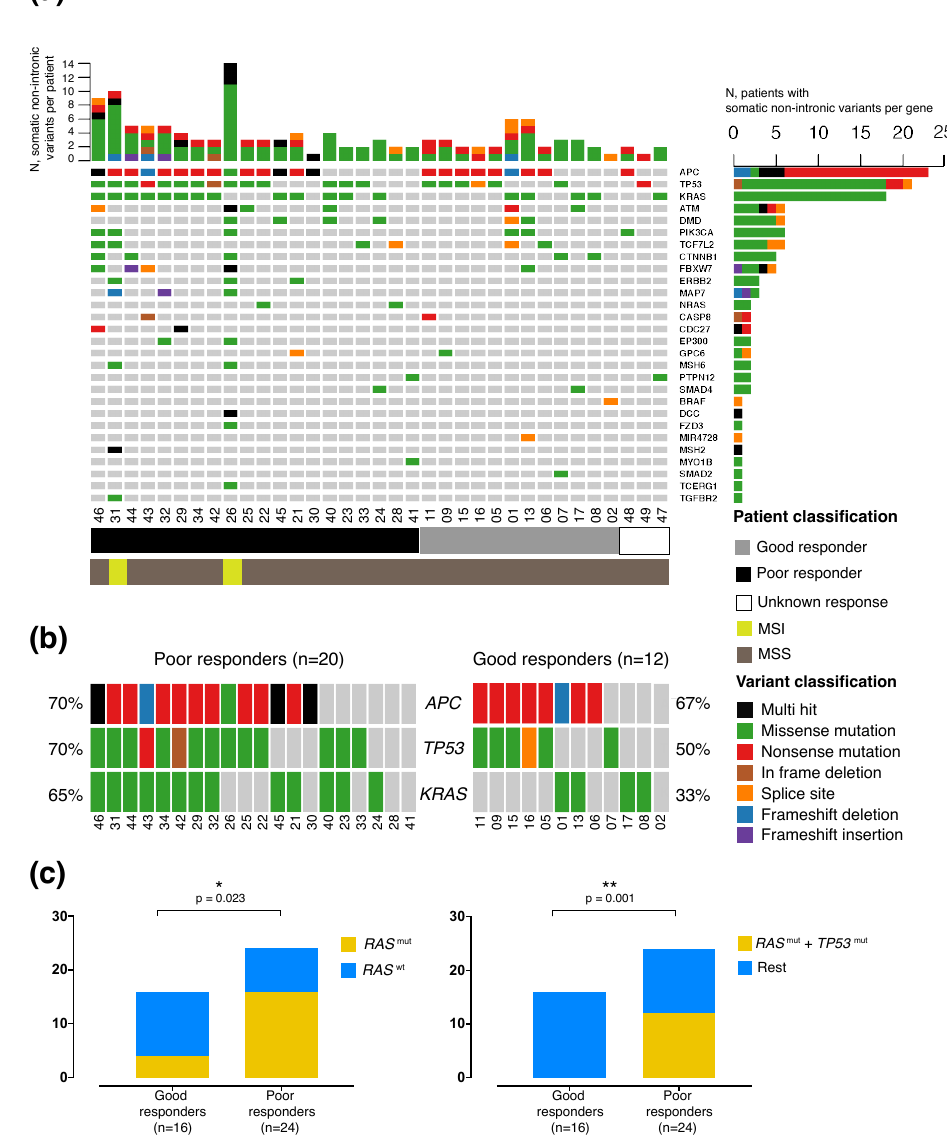
Figure 4. Spectrum of non-intronic somatic mutations found with the GeneRead Colorectal Cancer Panel in the LARC cohort ( n = 35). ( a ) Waterfall plot depicting the type of somatic variants found per patient (columns) and per gene (rows). Intronic variants were not included. Colors indicate the type of mutation detected, as specified by the legend. Column bars at the top of the plot represent the number of non-intronic somatic variants present in each patient. Patients 26 and 31 were classified as having microsatellite instability (MSI). Color references at the bottom of the waterfall plot depict nCRT response according to the Consensus Response classification (CR) (black: poor response, grey: good response, white: off-treatment) and microsatellite status for each patient (brown: microsatellite stability [MSS], yellow: MSI). Bars to the right of the waterfall plot represent the number of patients who present somatic mutations in each evaluated gene. ( b ) Mutational status of the three most frequently mutated genes ( APC , TP53 and KRAS ) in good and poor nCRT responders harboring non-intronic somatic mutations in any of those genes. ( c ) Contingency analysis of the presence of RAS mutations (left) or the co-occurrence of mutations in RAS and TP53 (right) in good and poor responders. These plots and calculations include patients not evaluated by NGS panel but clinically tested for RAS / TP53 mutations (See Appendix A1 for more details).The significance of the differences was tested by Fisher’s exact test (* p < 0.05, ** p <